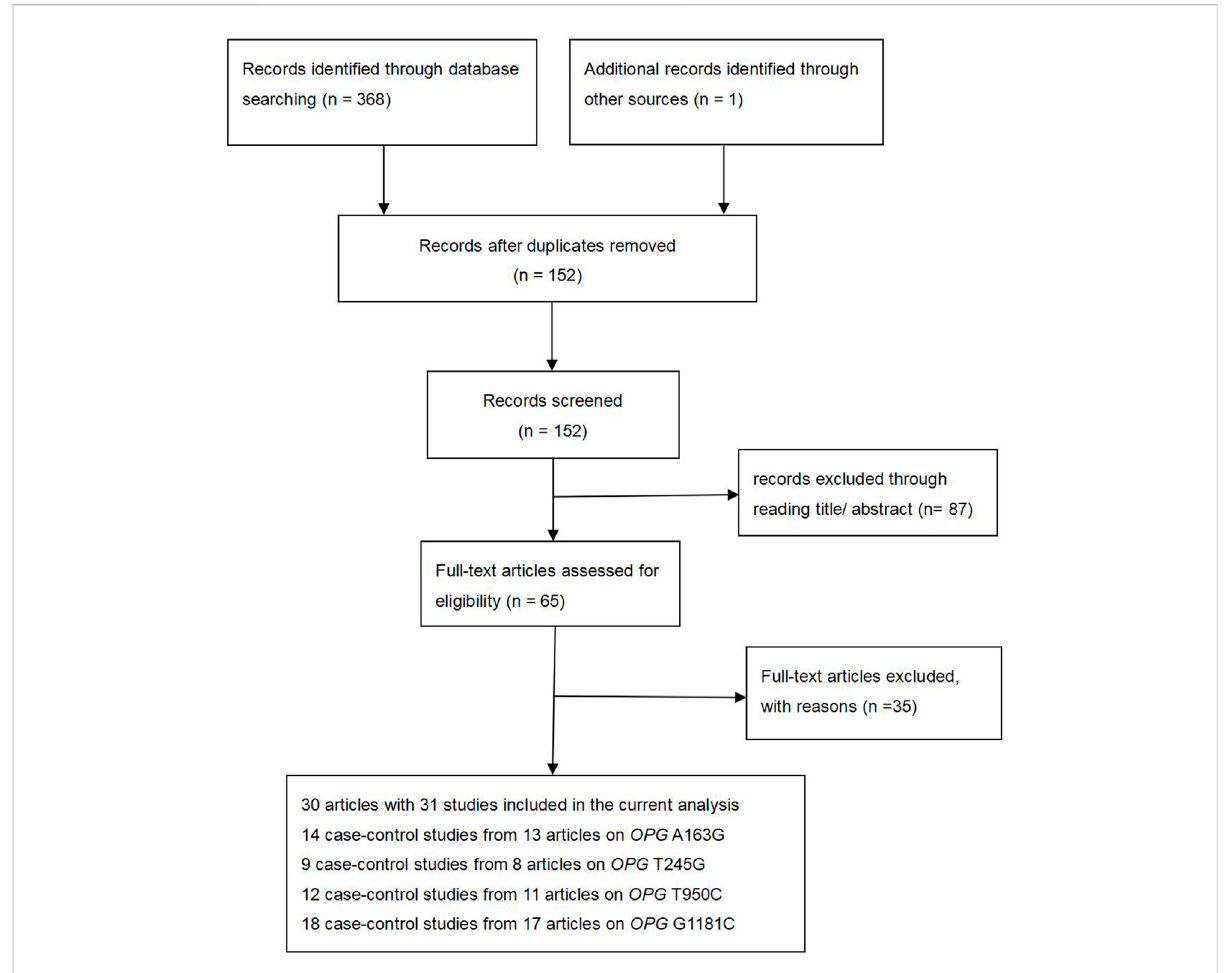
FIGURE 1 Flow diagram of the literature